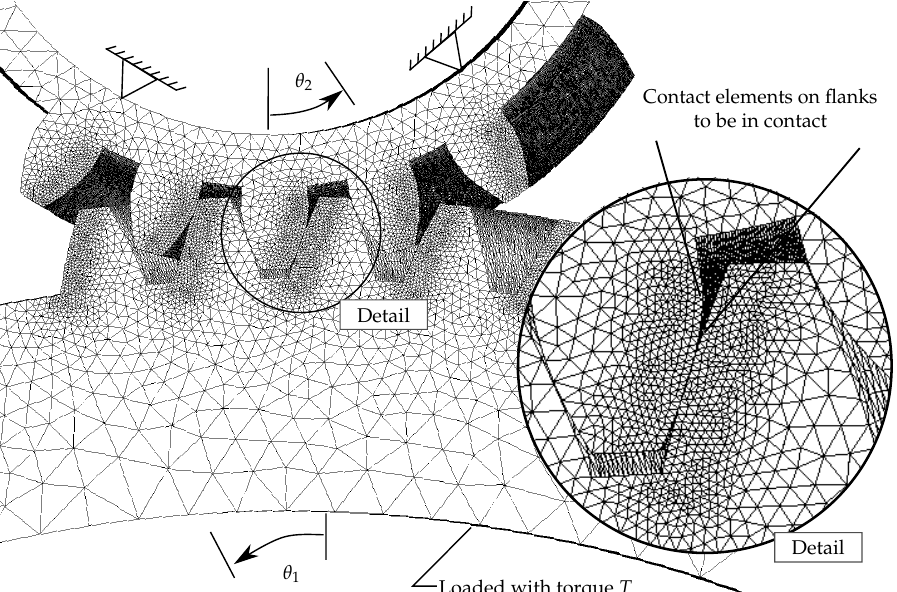
Figure 3. Schematic overview of the finite element setup to determine the mesh stiffness of two mating helical gears in a specific angular position within a mesh cycle.